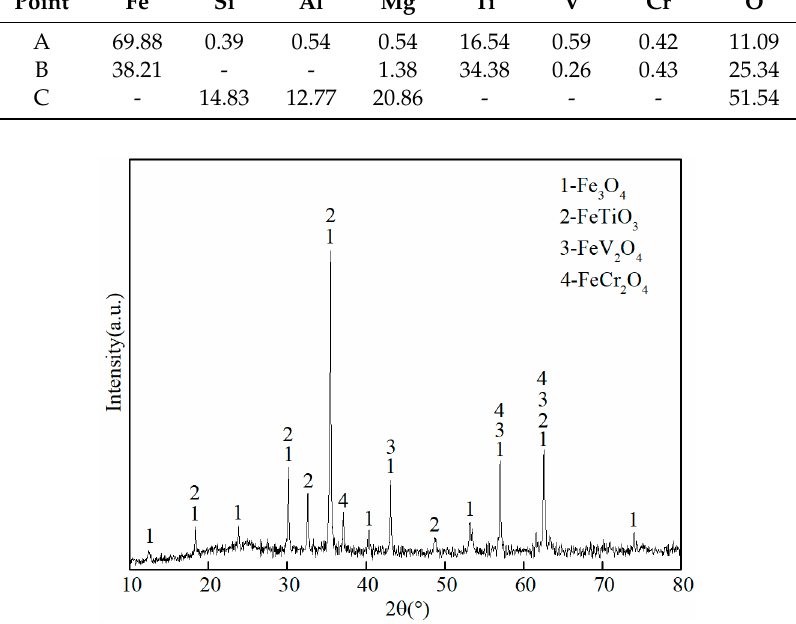
Figure 2. XRD pattern of the